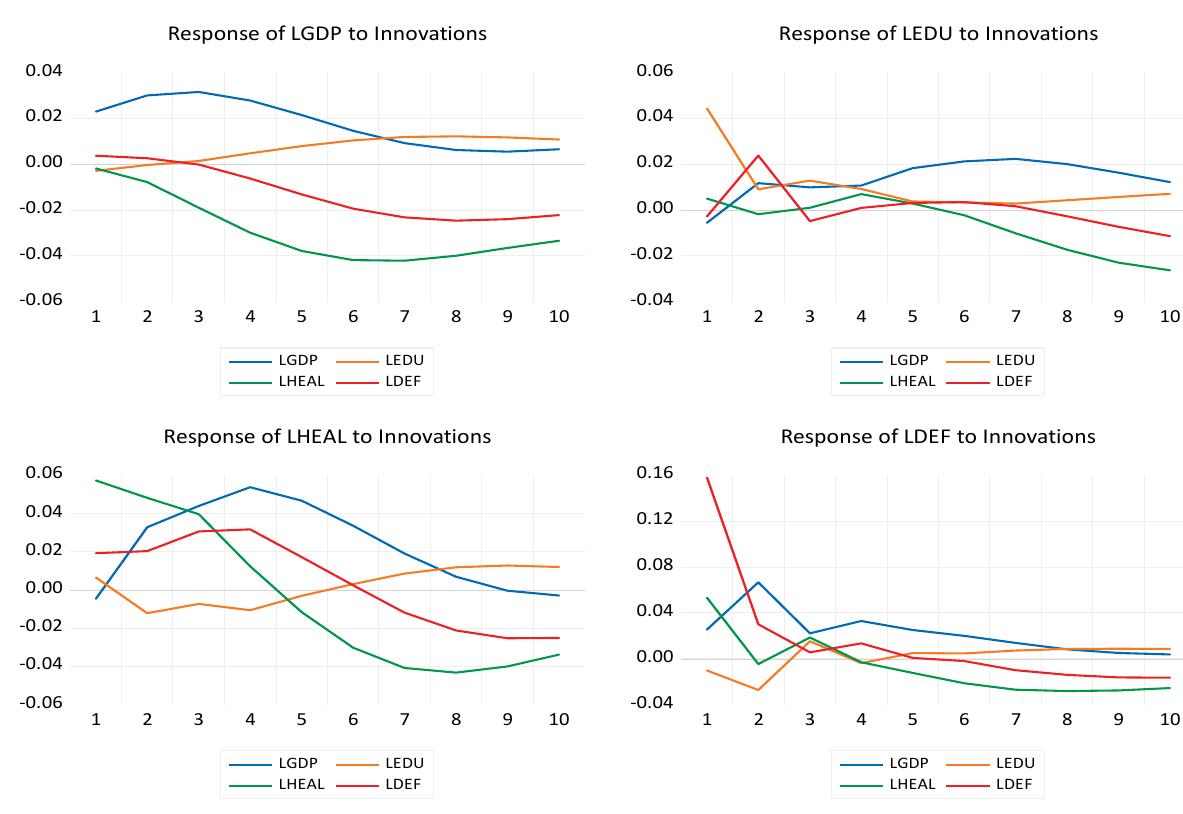
Figure 3. Impulse response analysis graph.